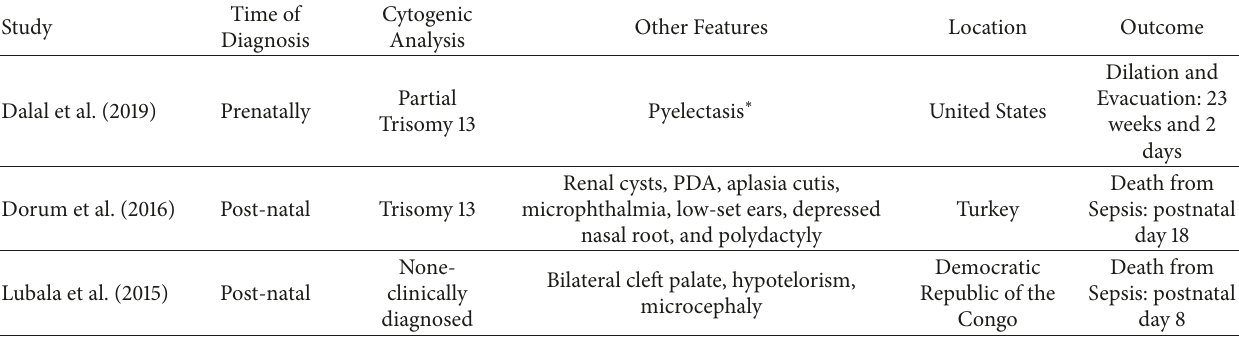
Table 1: Cases of Sacrococcygeal Teratoma associated with Trisomy 13.